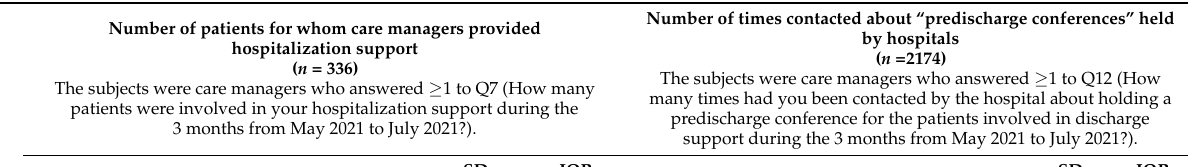
Table 4. Associations between chief care manager certification status and nursing license status of care managers and the number of patients for whom they provided hospitalization/discharge